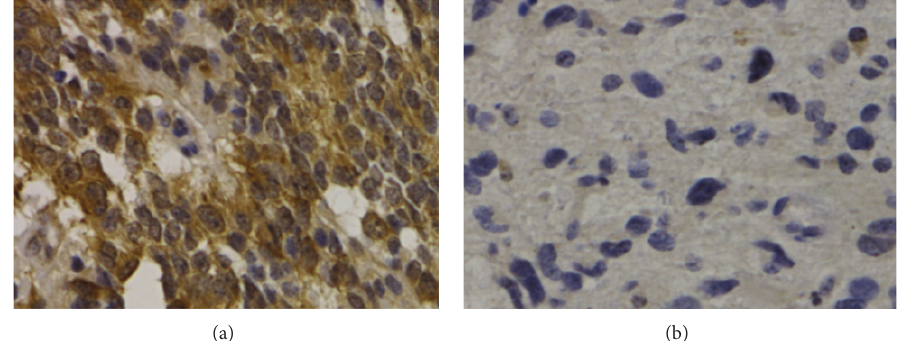
Figure 3: The expressions of Girdin in Gliomas tissues ( ×400 ). (a) High-grade gliomas stained with Girdin; (b) Low-grade gliomas stained with Girdin.